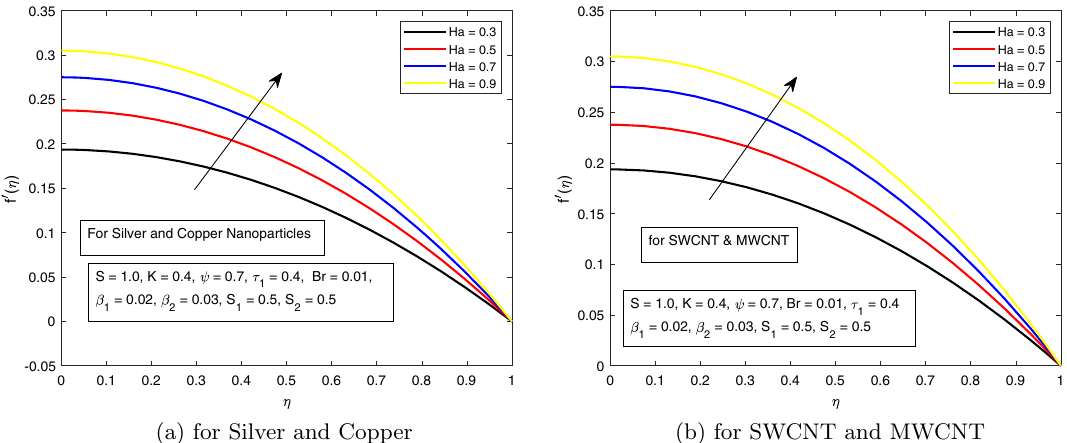
Figure 12. Influence of φ 2 on velocity profile f ′ ( r ) for the hybrid nanofluid combination of ( a ). Ag and Cu , ( b ) SWCNT and MWCNT .